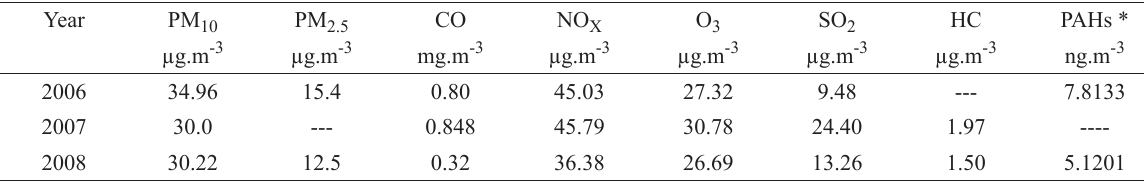
Average pollutants concentrations in the MAPA in 2006, 2007 and 2008.